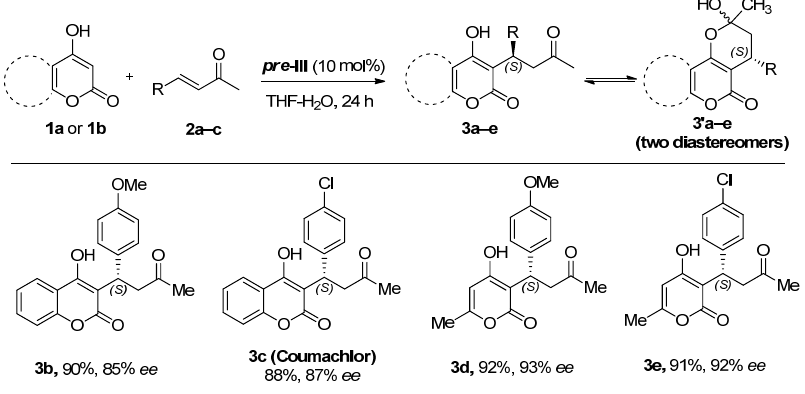
Figure 4. The reaction scope.